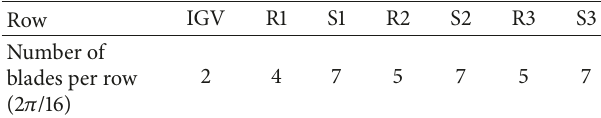
Table 2: Number of blades of CREATE.